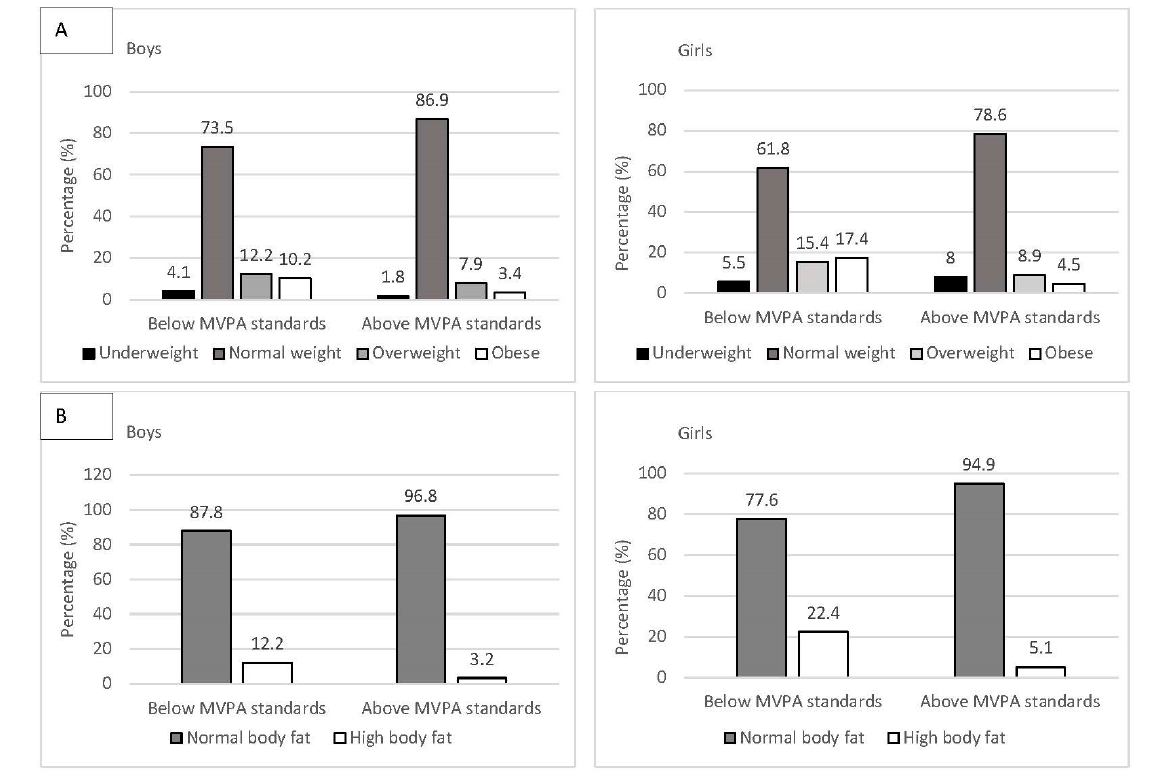
Figure 2. Percentage of students in each ( A ) weight status group (underweight, normal weight, overweight, and obese) and ( B ) with normal vs. high body fat levels, separately for those who met vs. do not meet current moderate-to-vigorous physical activity (MVPA) standards ( ≥ 60 min of MVPA/day) and separately for boys and girls. Table 3. Differences in body composition between students who meet vs. do not meet current moderate-to-vigorous physical activity standards ( ≥ 60 min of MVPA/day), with sex as a moderator. Not Meeting MVPA Standards Meeting MVPA Standards ( n =